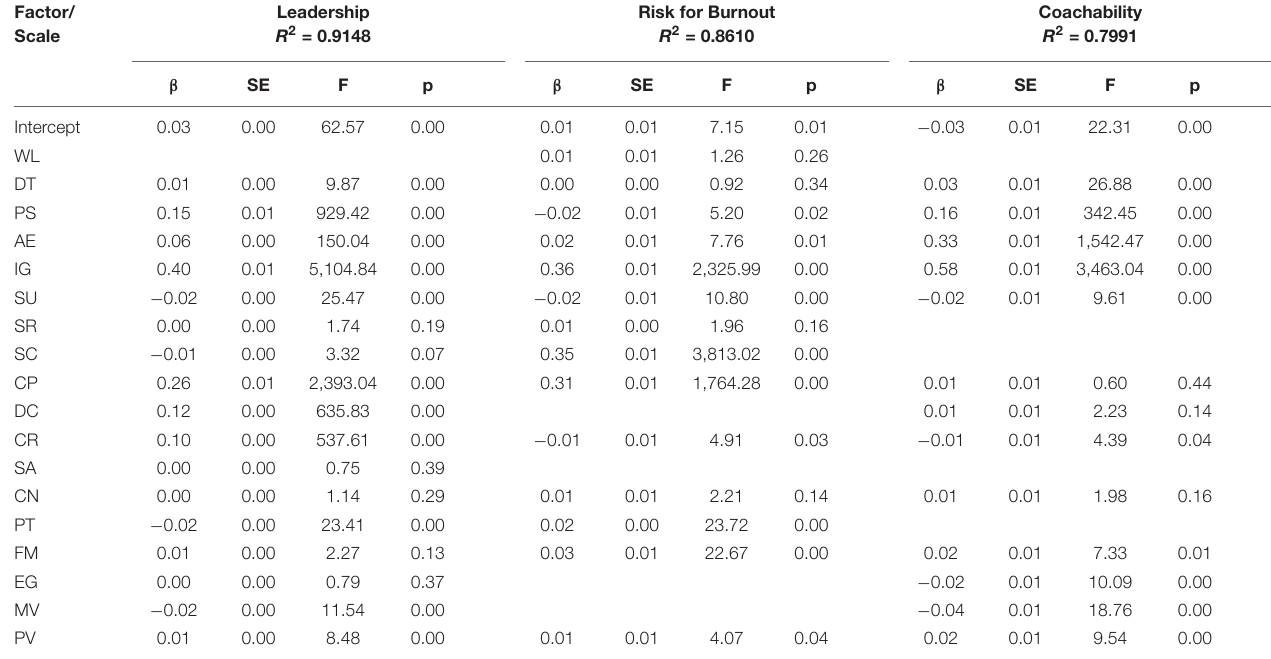
TABLE 8 | Predicting Leadership, Risk for Burnout and Coachability with the MMP ( n =3,039). Factor/ Scale